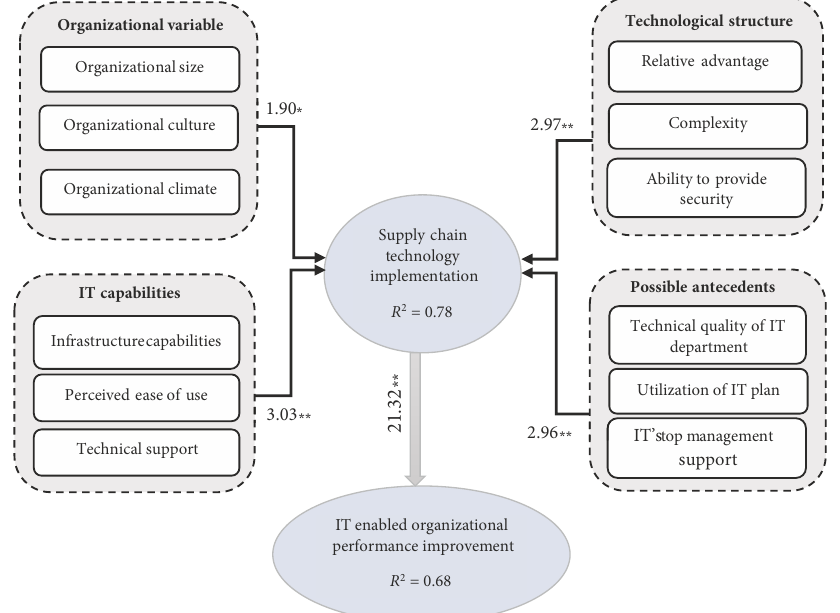
Figure 2. Research model based on PLS results ( notes :* – p < 0.1; ** – p <